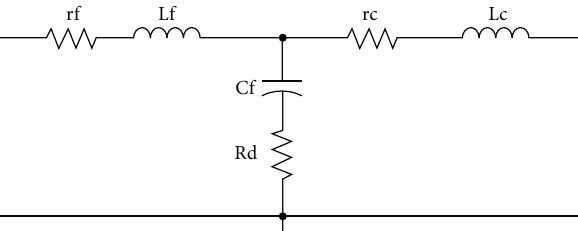
Figure 10: Distribution